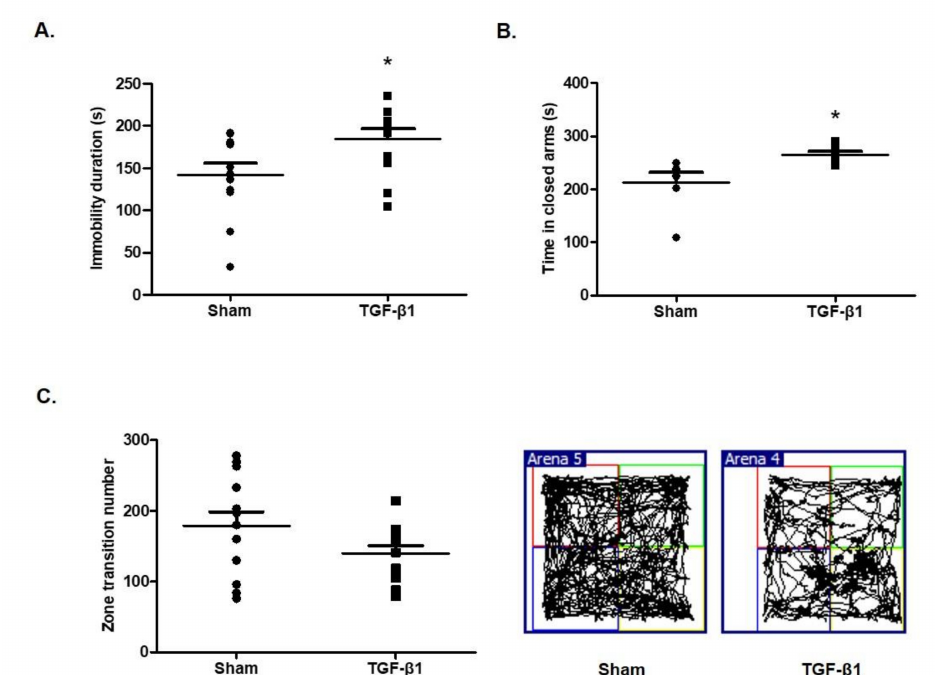
Figure 1. Effects of transforming growth factor (TGF)- β 1 on depressive and anxious behaviors in mice. The C57BL/6 mice were intracranially injected with TGF- β 1 (100 ng/mice) and the following measurements were performed: ( A ) Immobility duration time by forced swimming test; ( B ) spending time in the closed arms in an elevated plus maze test; ( C ) zone transition numbers in an open field test. Data are presented as mean ± SEM (N = 8–10). * p < 0.05 compared with the sham